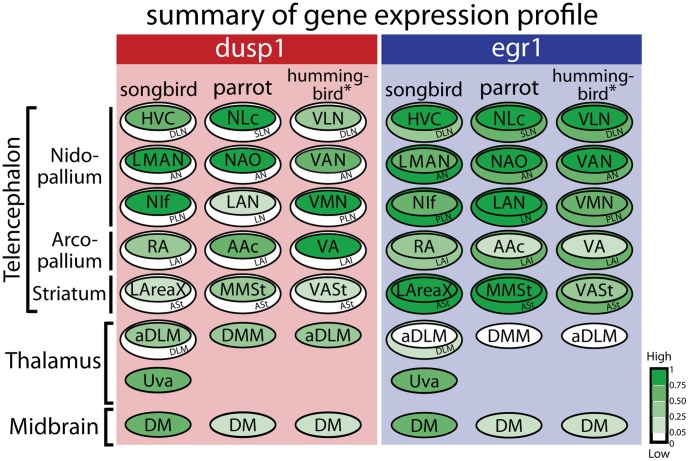
Summary of gene induction in vocal and movement-activated areas of vocal learners.Intensity of green indicates relative levels of activity-induced dusp1 or egr1 induction in each area, determined from the in situ hybridizations (see methods). White (0), no detectable induction; Dark Green (1), highest induction levels. Gene induction in song nuclei is due to singing, and in regions adjacent to song nuclei is due to moving. * The values for hummingbirds are an average of several species: sombre hummingbird (n  = 3 singing, n  = 3 silent), Anna’s hummingbird (n  = 2 singing, n  = 1 silent), and rufous-breasted hermit (n  = 2 singing, n  = 1 silent). For anatomical abbreviations, see Table 1.